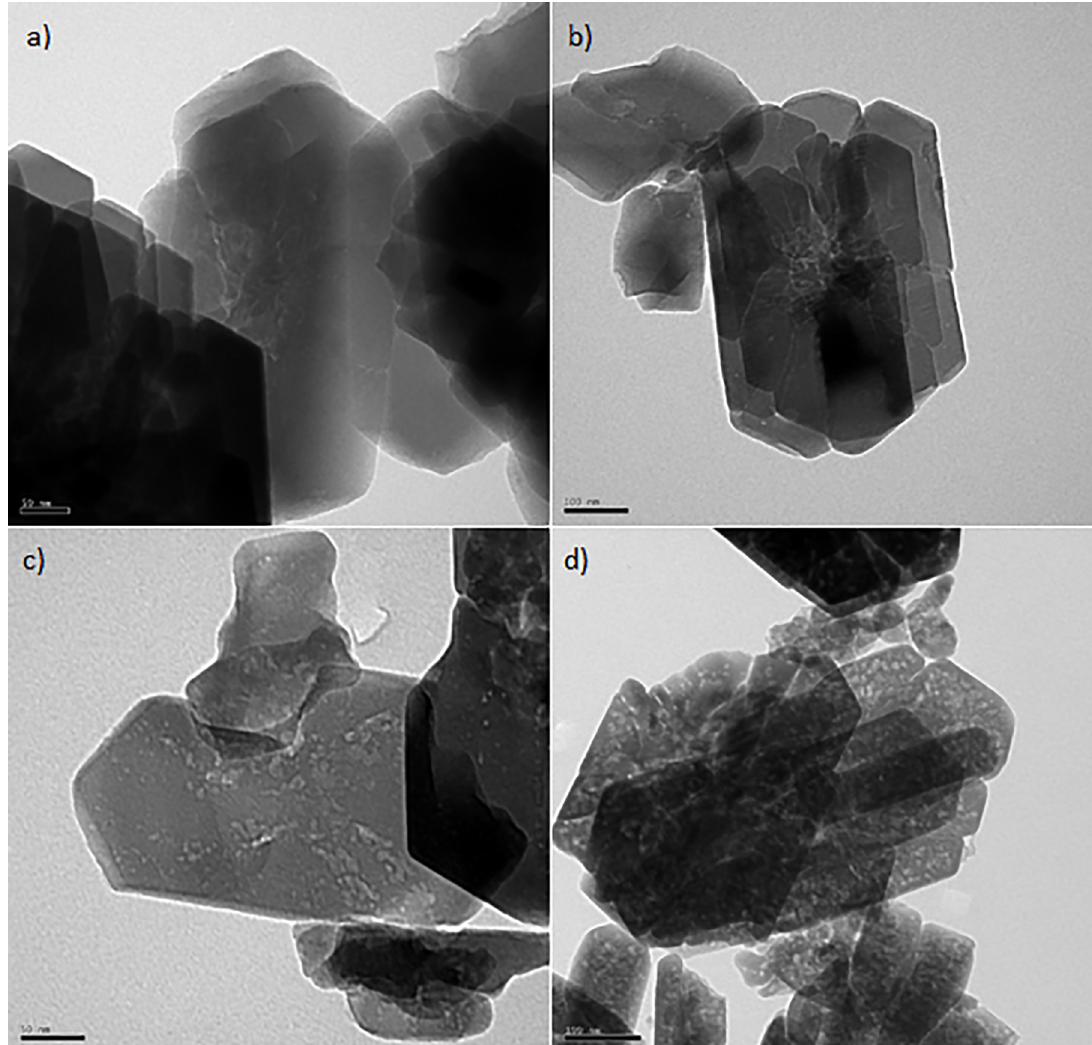
Figure 4. TEM images of the H-ZSM-5 zeolites: a) and b) H-ZSM-5(D1); c) H-ZSM-5(D2); and